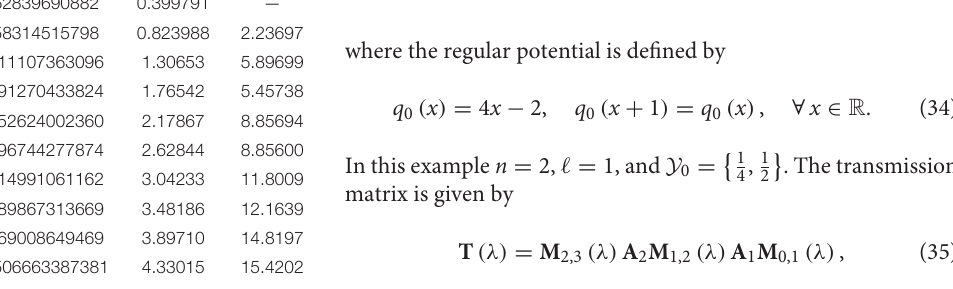
D (λ) from Example e